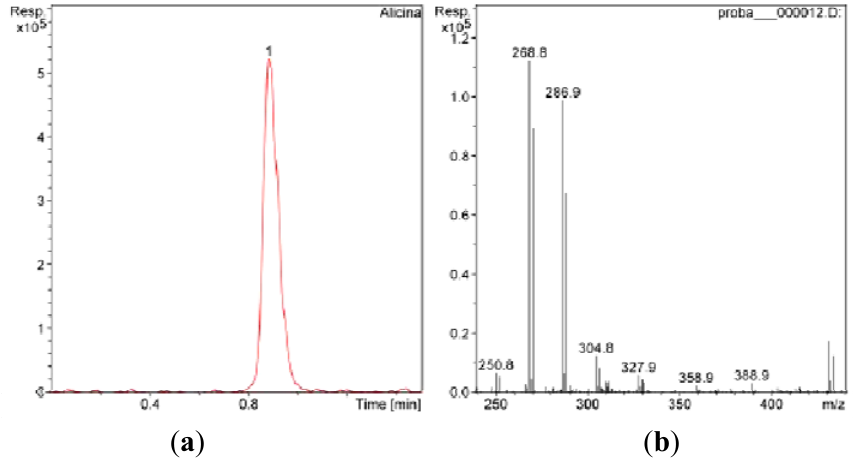
( b ) MS-MS spectra of allicin.